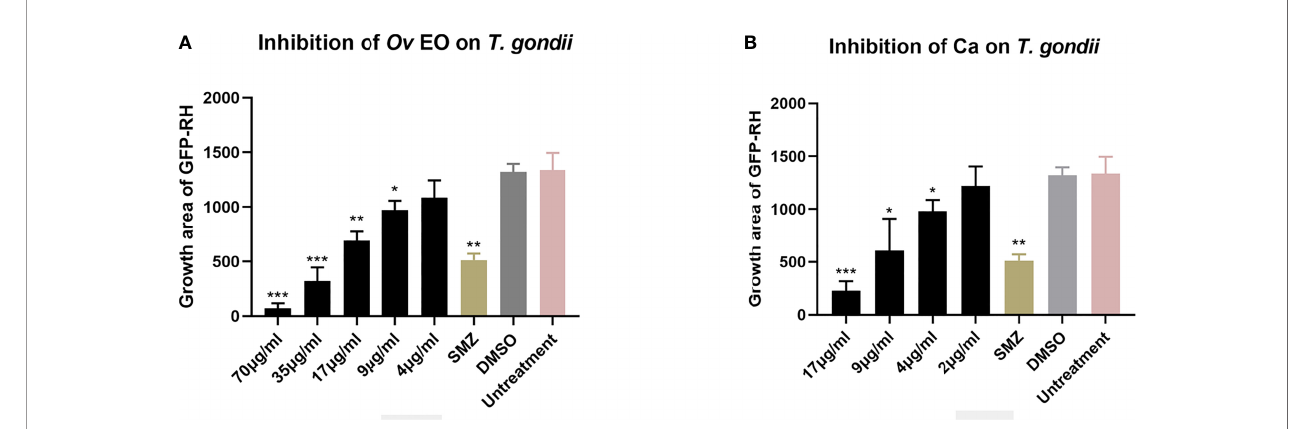
FIGURE 4 | Statistical analysis of the inhibition effect of Ov EO and Ca in anti- T. gondii . Data analysis based on fl uorescence area of GFP-RH. Each bar represents the mean ± SD of three wells per group. * P < 0.05, ** P < 0.01, *** P < 0.001 compared with untreatment group. (A) Anti- T. gondii activity of Ov EO, and (B) Anti- T. gondii activity of Ca.